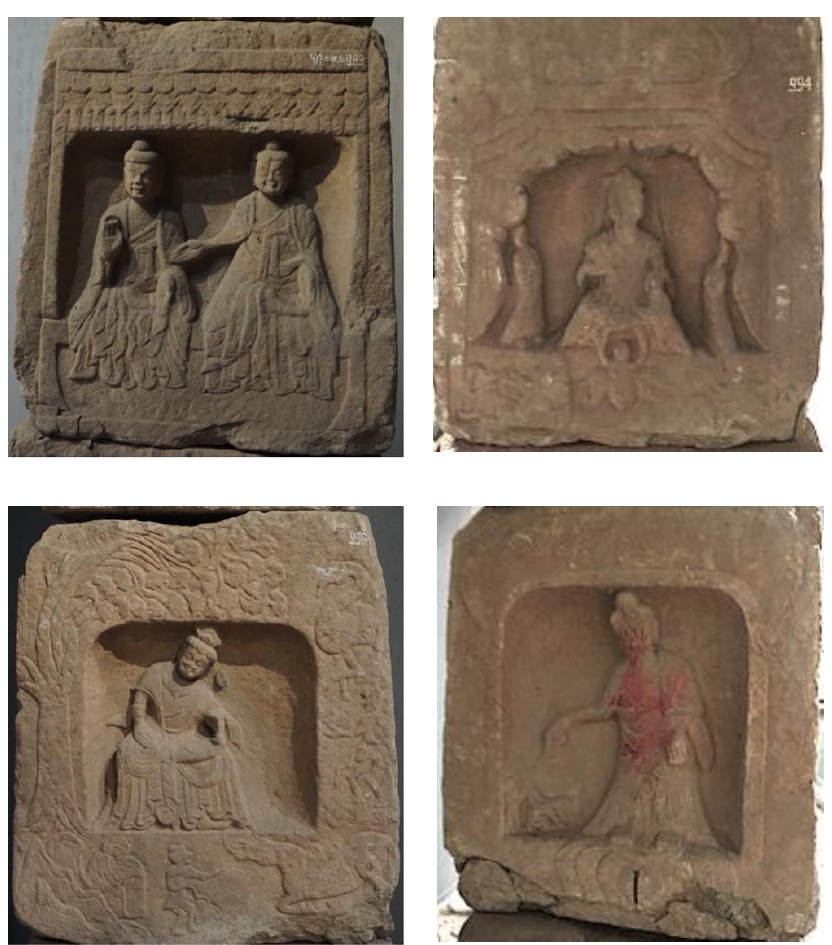
Figure 10. Scenes no. 993–96, stone block from Nannieshui. Early sixth century, Northern Wei. Shanxi province. Photographs taken by the author.